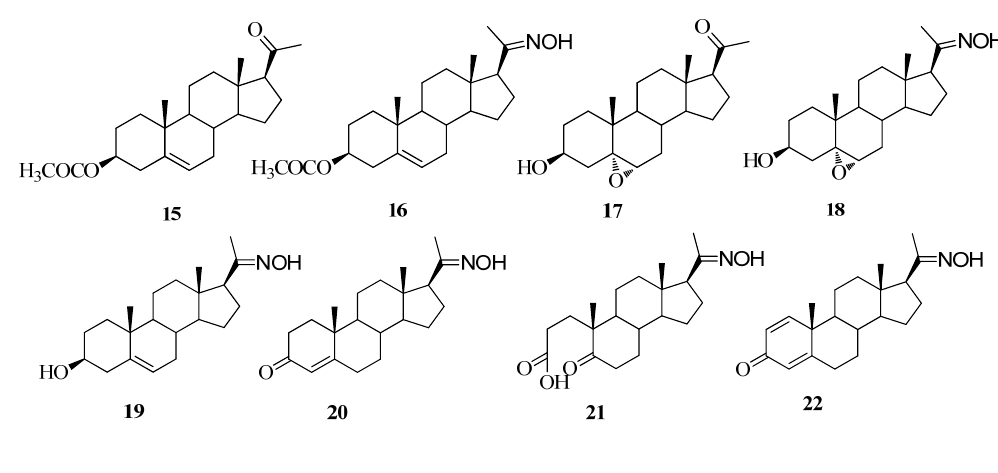
Figure 2. Previous synthesized compounds